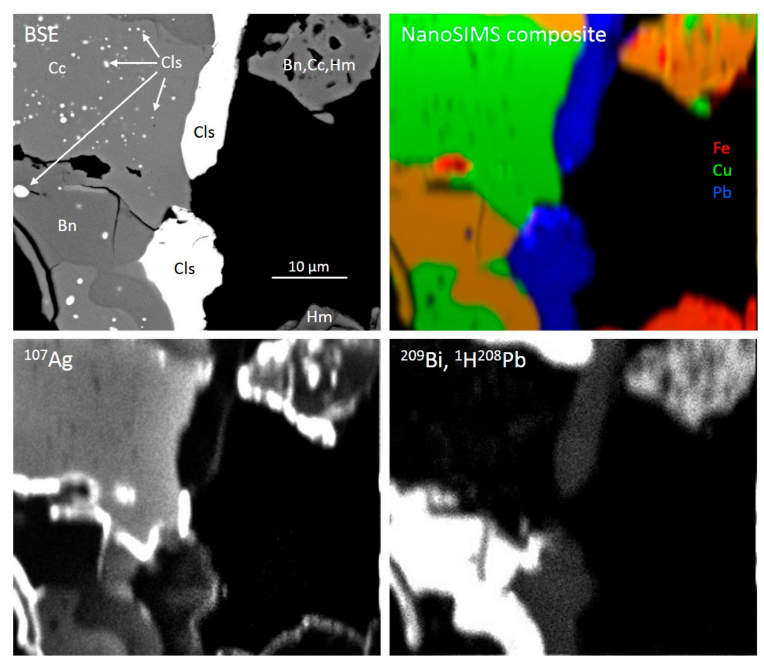
Figure 3. The BSE (top left) and nanoSIMS images of sample 01FC13 showing two large clausthalites (Cls) in bornite / chalcocite. Sub-micron clausthalite inclusions are found throughout the chalcocite, and—to a lesser extent—in bornite. The composite image represents overlapping nanoSIMS maps of Fe (red), Cu (green), and Pb (blue). Note that orange is the result of a red and green overlap